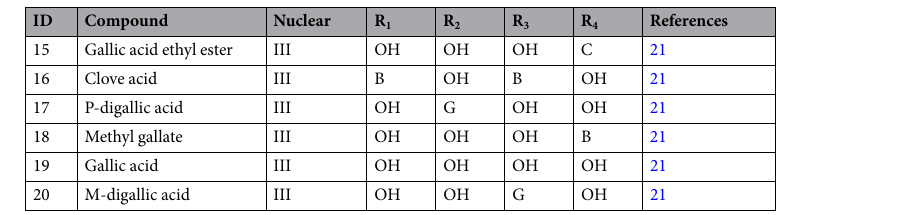
Table 3. Type III Turkish galls